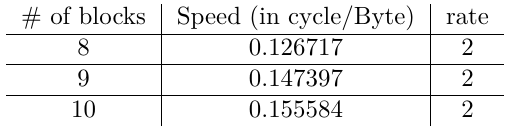
Table 2: Comparison of the performance of the round function having different number of blocks at the same rate . # of blocks Speed (in cycle/Byte) rate 8 0.126717 2 9 0.147397 2 10 0.155584